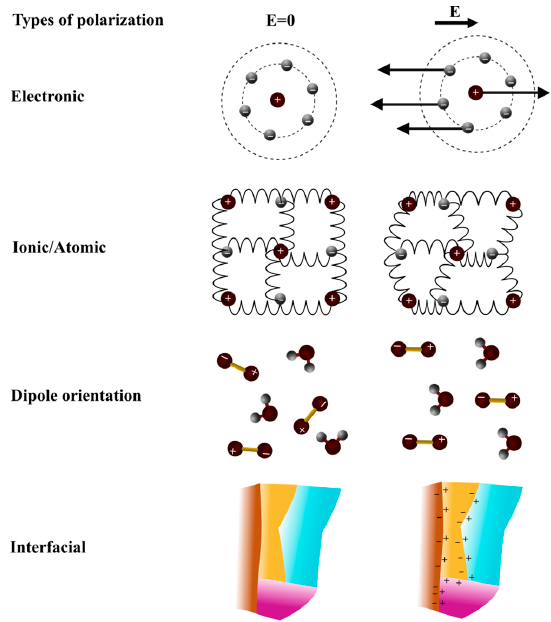
Figure 2. Schematic representation of four types of polarization [32].